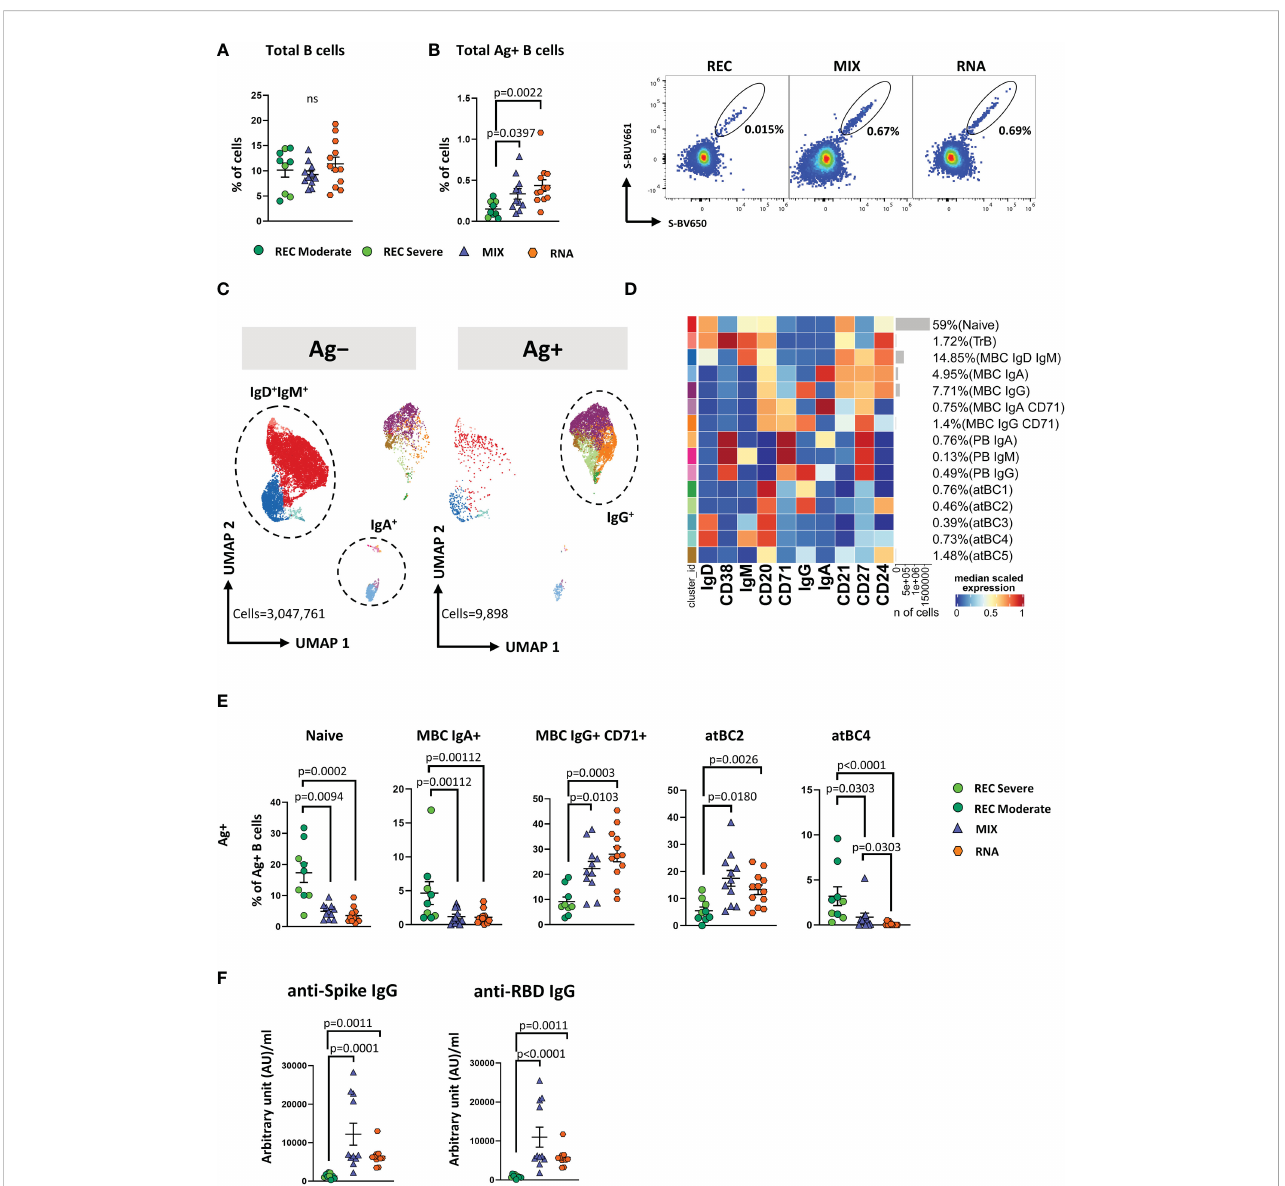
FIGURE 4 Immune phenotyping of antigen-speci fi c CD19 + B cells. (A) Dot plots show the total percentage of CD19 + B cells. Kruskal – Wallis test with Benjamini – Hochberg correction for multiple comparisons was used to test the differences among the three groups. (B) Dot plots show the total percentage of antigen-speci fi c CD19 + B cells (left); representative dot plots showing manual gating analysis of Ag + B cells from REC, MIX, and RNA. Numbers in the dot plots indicate the percentage of cells identi fi ed by the gates (right). Kruskal – Wallis test with Benjamini – Hochberg correction for multiple comparisons was used to test the differences among the three groups. (C) UMAP plot shows the 2D spatial distribution of 3,057,659 cells from nine donors who recovered from SARS-CoV-2 infection (REC, severe = 4 and moderate = 5) and 23 vaccinated donors (MIX = 11 and RNA = 12) embedded with FlowSOM clusters. Ag + , antigen-speci fi c CD19 + B cells; Ag − , non-antigen- speci fi c CD19 + B cells. (D) Heatmap of the median marker intensities of the 10 lineage markers across the 15 cell populations obtained with FlowSOM algorithm after the manual metacluster merging. The colors of cluster_id column correspond to the colors used to label the UMAP plot clusters. The color in the heatmap is referred to the median of the arcsinh marker expression (0 – 1 scaled) calculated over cells from all of the samples. Blue represents lower expression, while red represents higher expression. Light gray bar along the rows (clusters) and values in brackets indicate the relative sizes of the clusters. N, naive; TrB, transitional B cells; MBC, memory B cell; atBC, atypical B cell. (E) Dot plots show the percentage of 15 Ag + B cell clusters among nine donors who recovered from SARS-CoV- 2 infection (REC, severe = 4 and moderate = 5) and 23 vaccinated donors (MIX = 11 and RNA = 12). The central bar represents the mean ± SEM. GLMM test was used for the statistical analysis. Adjusted P-values are reported in the fi gure. (F) Anti-spike and anti-RBD IgG concentrations in plasma samples from REC, MIX, and RNA individuals. Kruskal – Wallis test with Benjamini – Hochberg correction for multiple comparisons was used to test the differences among the three groups. Adjusted P-values are indicated in the fi